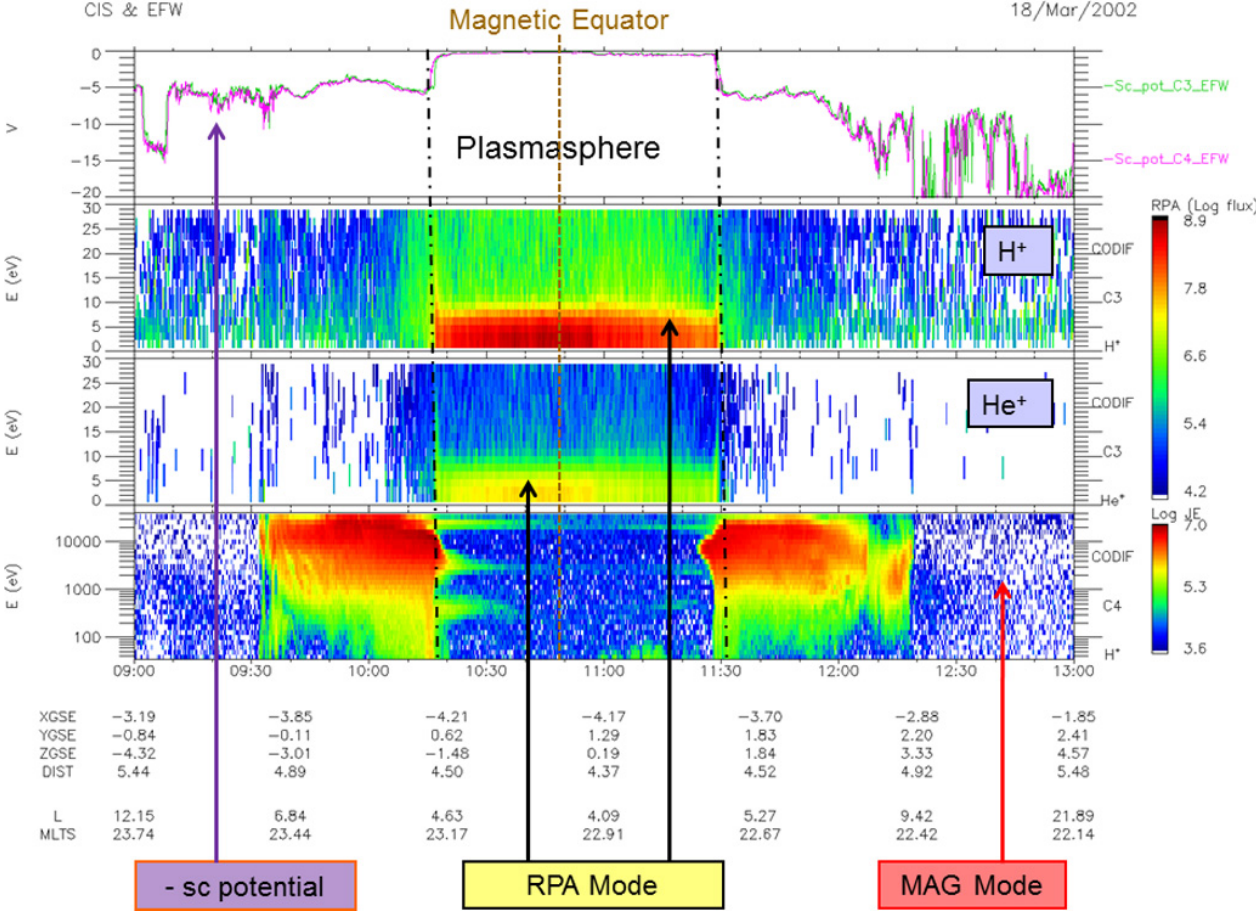
Fig. 3. Cluster C3 (spacecraft 3) and C4 data for the 18 March 2002 event. From top to bottom: negative of the spacecraft potential measured by the EFW experiment (C3 in green and C4 in magenta), which is a proxy of changes in the plasma density; CODIF C3 omnidirectional H + and He + energy–time spectrograms in particle flux units (cm − 2 s − 1 sr − 1 keV − 1 ) in the RPA mode (low-energy ion detection); CODIF C4 omnidirectional energy–time spectrogram in particle energy flux units (keVcm − 2 s − 1 sr − 1 keV − 1 ) for H + in normal magnetospheric